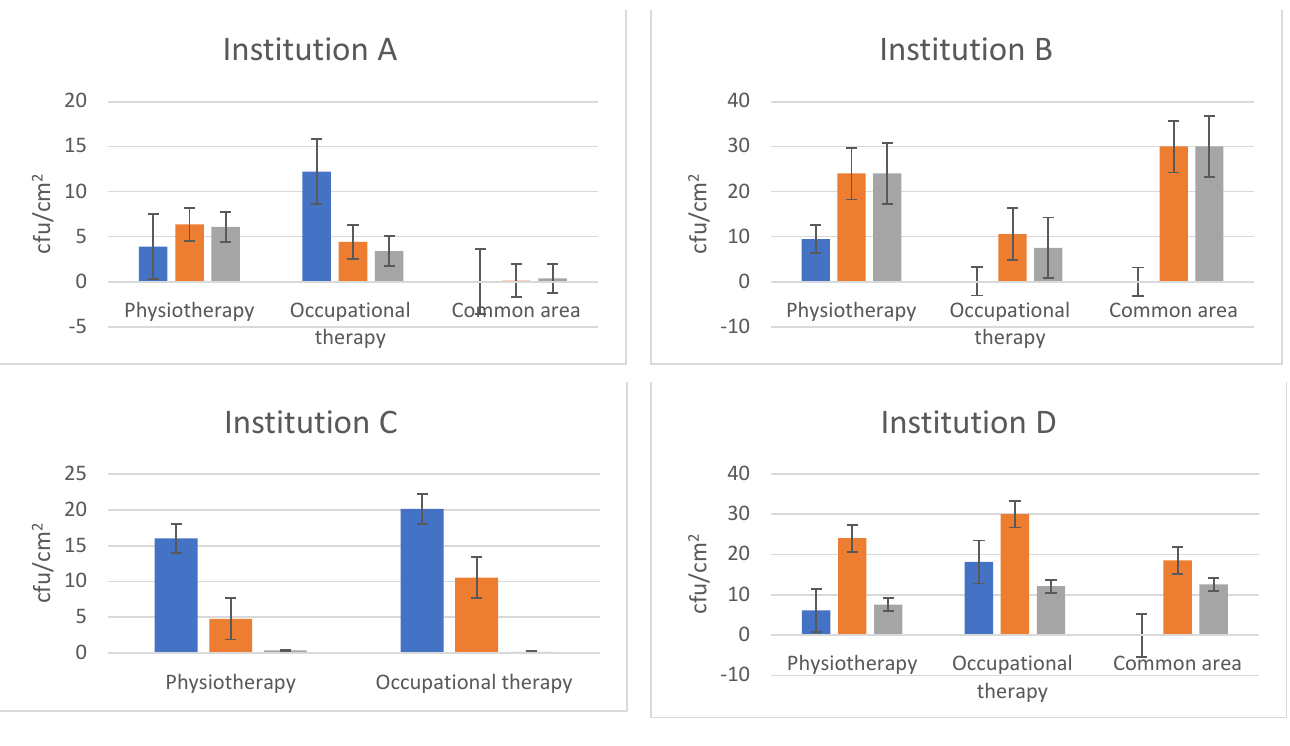
Figure 1. Average CFU/cm 2 values across facilities sampled on three different occasions: before use, after use, and after disinfection.